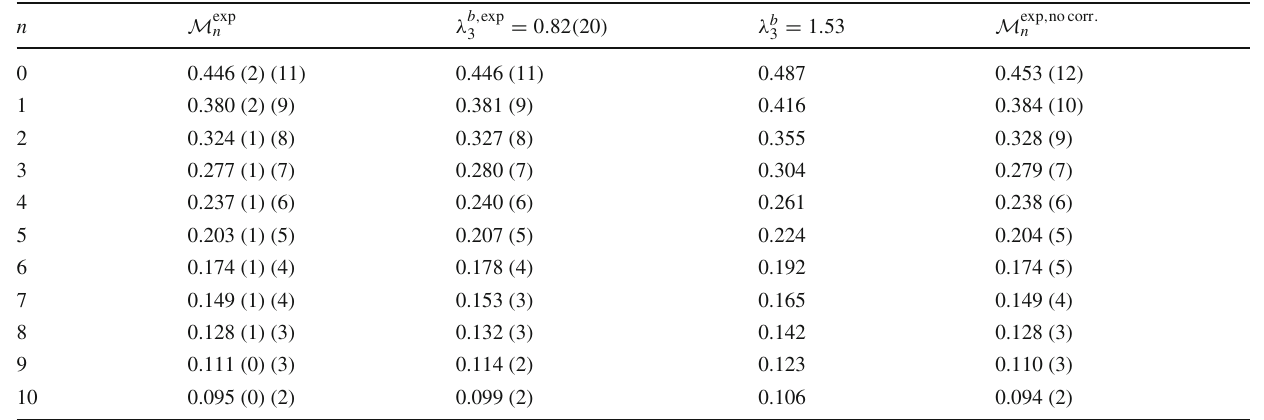
columns show the moments calculated from our ansatz for R b ( s ) with λ b , exp = 0 . 82 ( 20 ) (column 3) and λ b = 1 . 53 (column 4) as input. In 3 3 both cases, ˆ m b = 4 . 1802 GeV was used. The last column collects the experimental moments when BaBar data is used without any kind of correction or subtraction